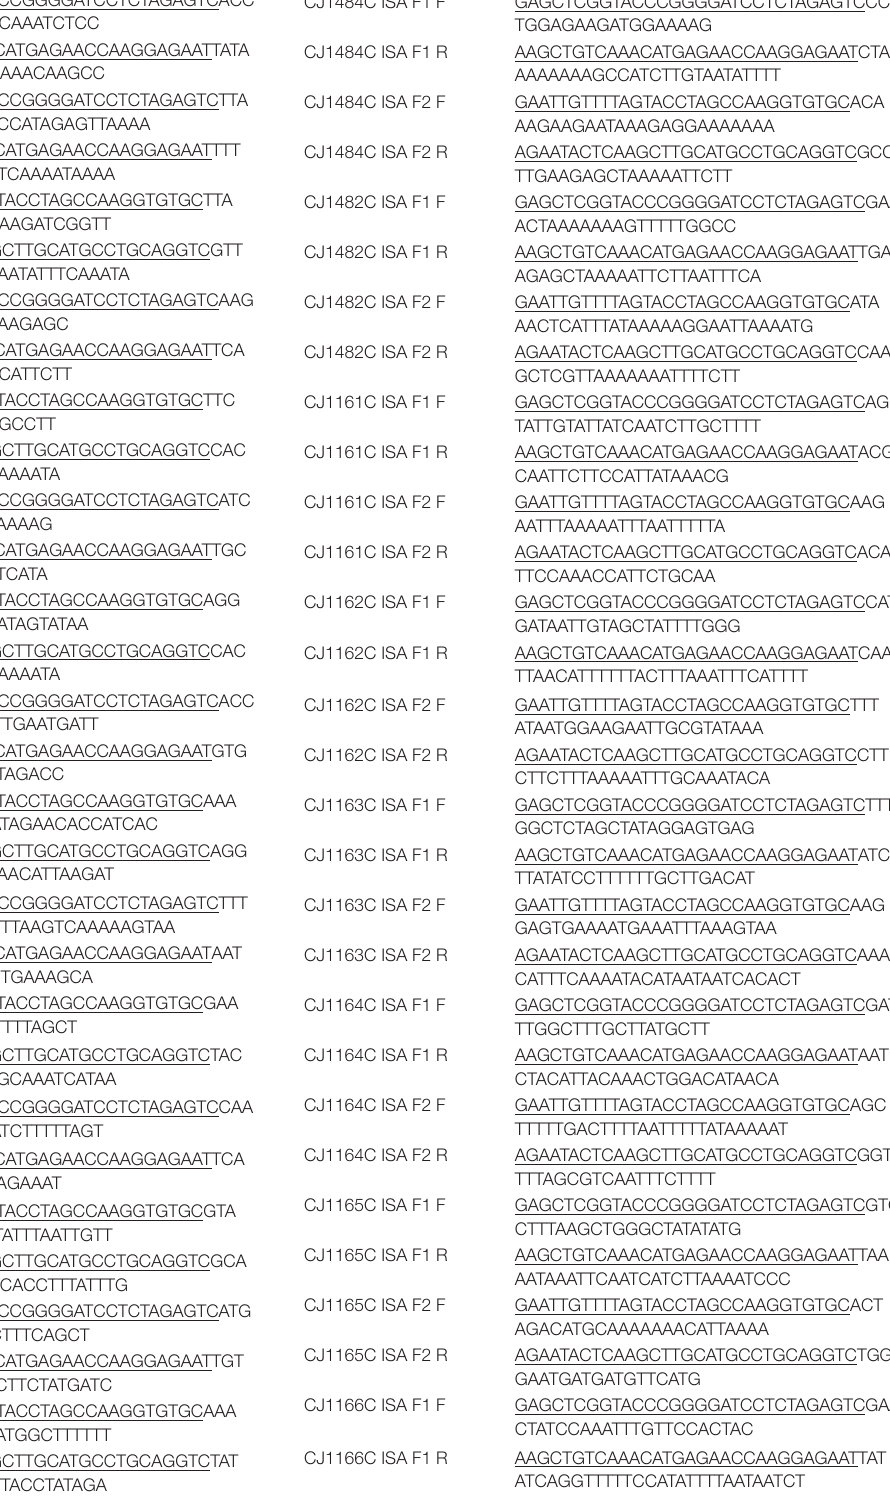
TABLE 2 | Primers used in this